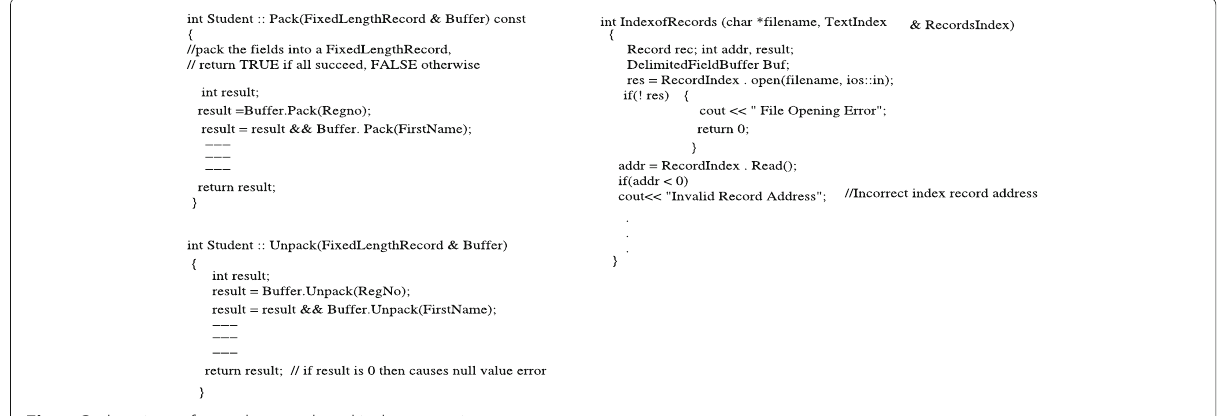
Fig. 7 Code snippet for pack, unpack and index